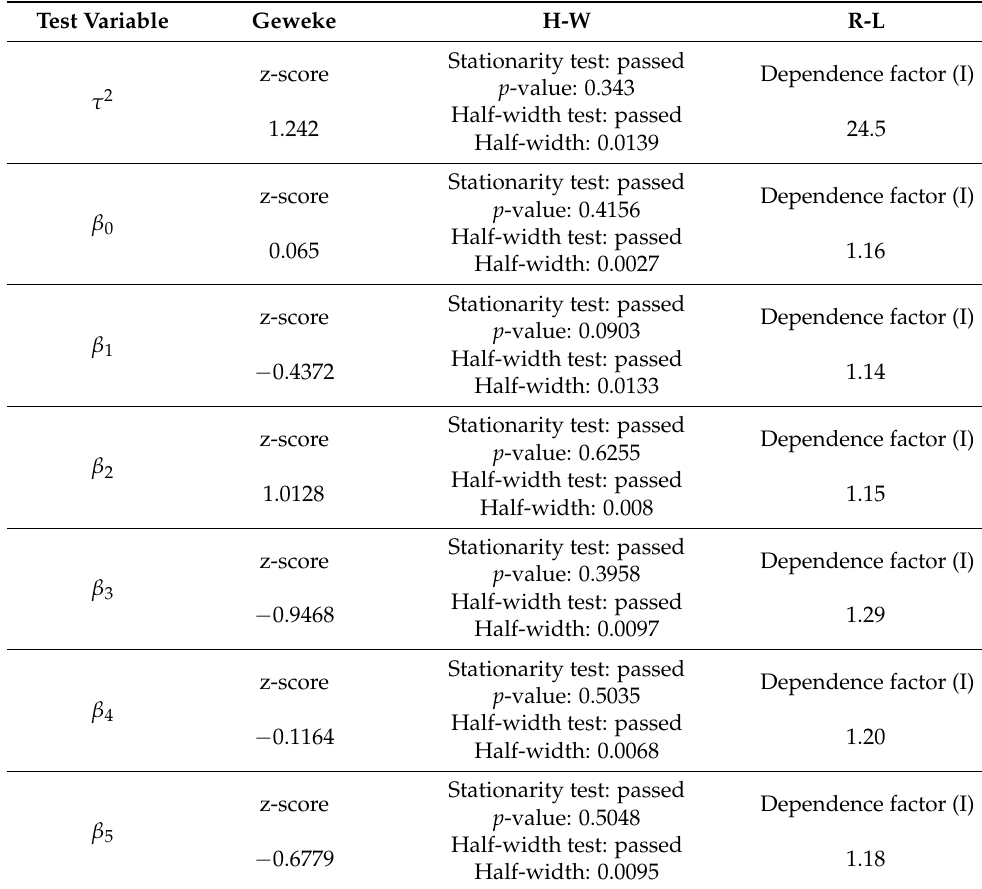
Table 9. MCMC convergence diagnostics for the values of τ 2 , β 0 , . . . , β 5 found for the case